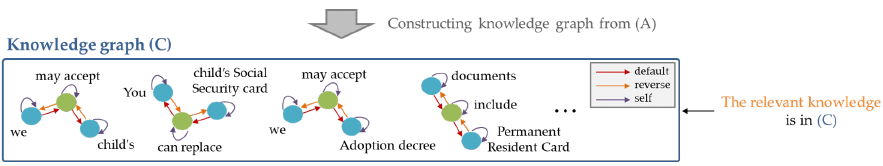
Figure 2. Capacity constraint problem when the model uses a long knowledge document.